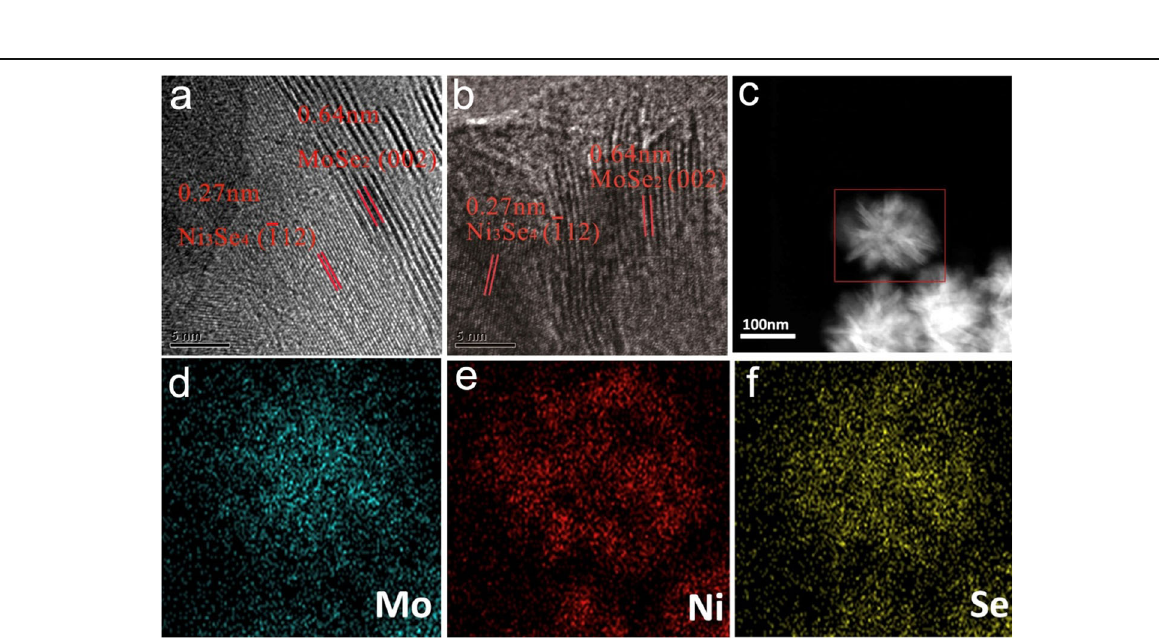
Fig. 4 HRTEM images ( a and b ), HAADF image ( c ) and elemental maps ( d − f ) of Mo2Ni1